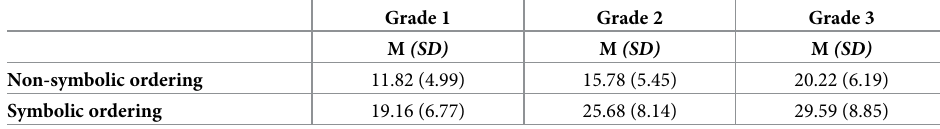
Table 1. Means (standard deviations in parentheses) of correctly solved items in the non-symbolic and symbolic order processing tasks in Grade 1, Grade 2, and Grade 3.